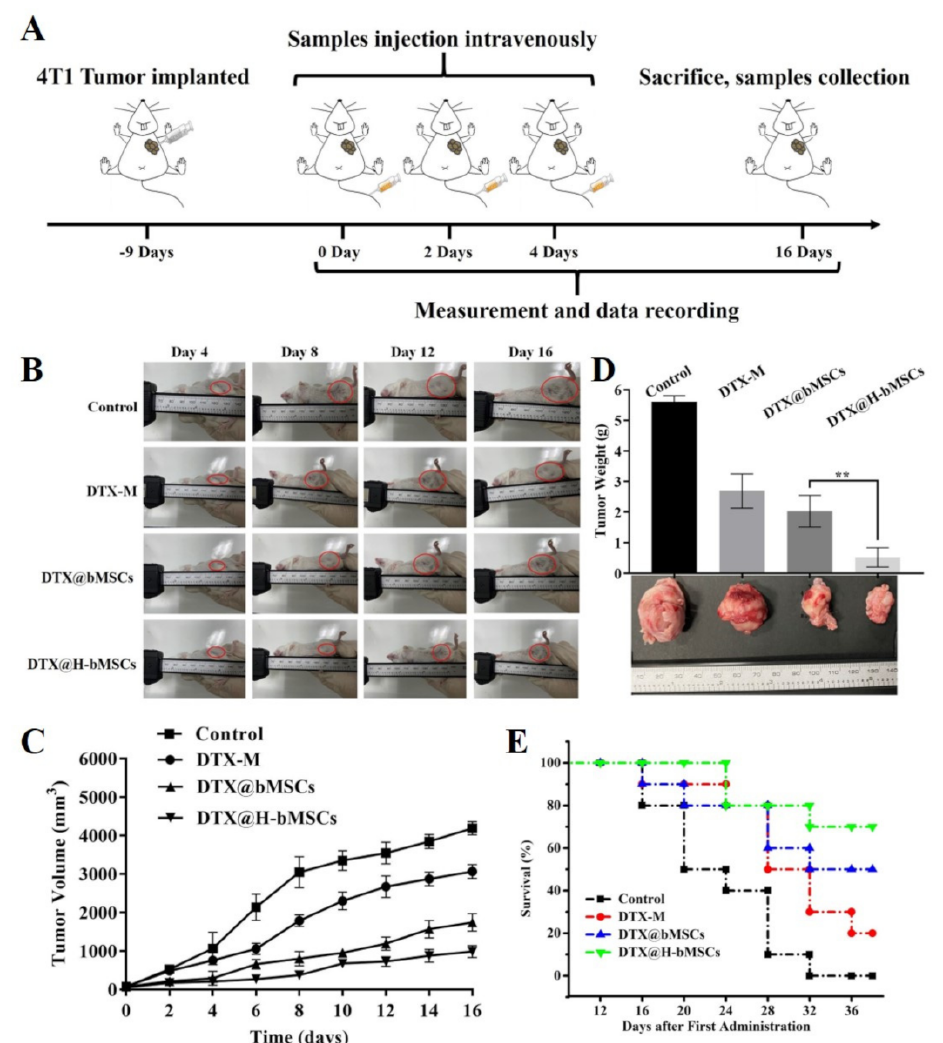
Figure 8. Antitumor activity of DTX@H-bMSCs in vivo. Administration route of DTX@H-bMSCs in mice model of in situ tumor transplantation of 4T1 cells ( A ); photographs of mice with different treatments at 4, 8, 12, and 16 days after administration ( B ); tumor growth curve of each group ( C ); weights and images of the tumors at 16 days after administration ( D ); survival curves after different treatments ( E ). (** p <